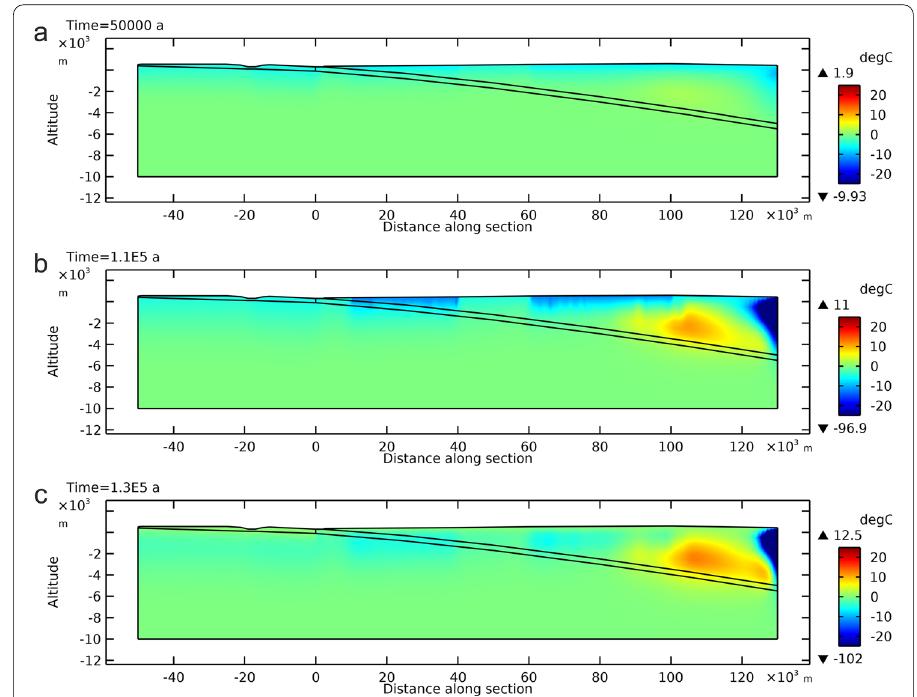
Fig. 16 Temperature difference between the paleo-temperature condition and the constant surface-temperature condition in the low Malm permeability scenario (i.e. difference between model runs D and F introduced in Fig. 3): a 80 ka ago (time (time 1.3E5 a). Vertical exaggeration equals =